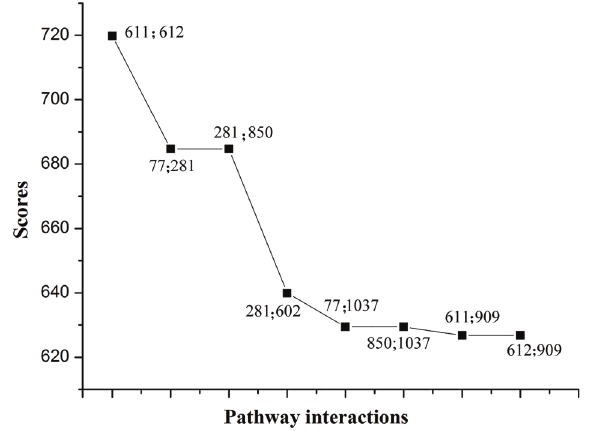
Figure 2. Score distribution of the top 8 pathway interactions with scores higher than 600; 77, APC/C-mediated degradation of cell cycle proteins; 281, DNA replication; 602, mitotic prometaphase; 611, mRNA splicing; 612, mRNA splicing-major pathway; 850, regulation of mitotic cell cycle; 909, RNA polymerase II transcrip- tion; 1037, synthesis of DNA. The numbers represent the pathway IDs, which were de fi ned based on alphabetical